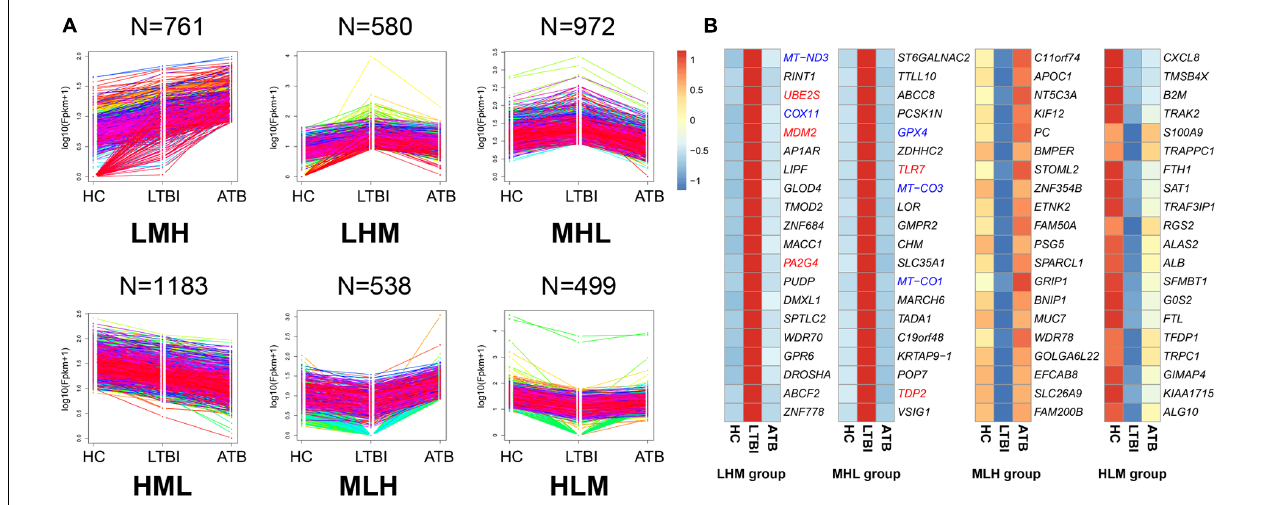
FIGURE 4 | The expression patterns of DEGs among the HC, LTBI, and ATB samples. (A) Six patterns were determined based on FPKM values, including LMH, LHM, MHL, HML, MLH, and HLM. (L, low expression level; M, medium expression level; H, high expression level; N, the gene numbers of each pattern). (B) Heatmaps of top-20 high expressed and low expressed DEGs (LHM, MHL, MLH, and HLM patterns in the LTBI samples): colors indicate the estimate of base 10 log ratio of expression levels that ranges from blue (low expression) to red (high expression). The five genes (PA2G4, MDM2, UBE2S, TLR7, and TDP2, labeled with red color) in LHM and MHL groups were enriched in “cell cycle” functional category. The five genes (COX11, MT-ND3, MT-CO1, MT-CO3, and GPX4, labeled with blue color) were enriched in “mitochondria disorder” functional category.